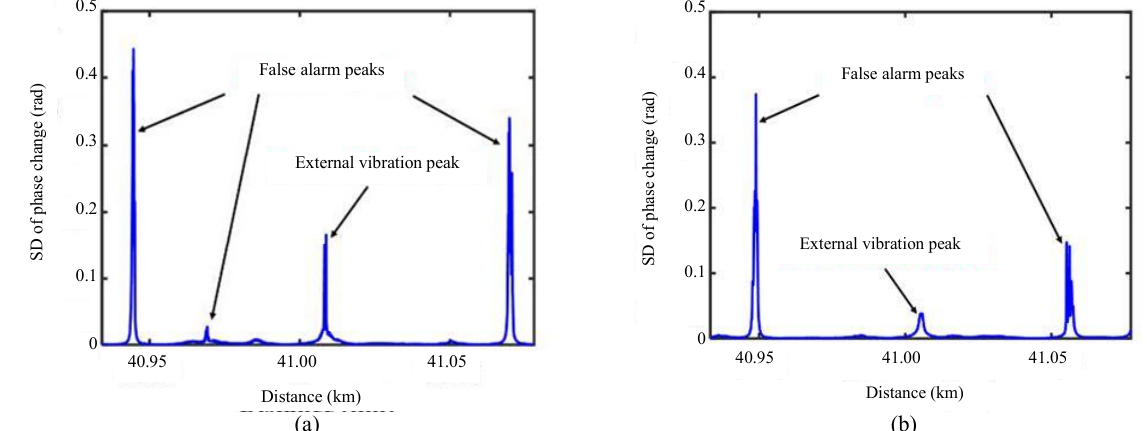
Fig. 3 Location information by calculating the standard deviation (SD) of phase difference for 75-consecutive traces of (a) Laser I and (b) Laser II.